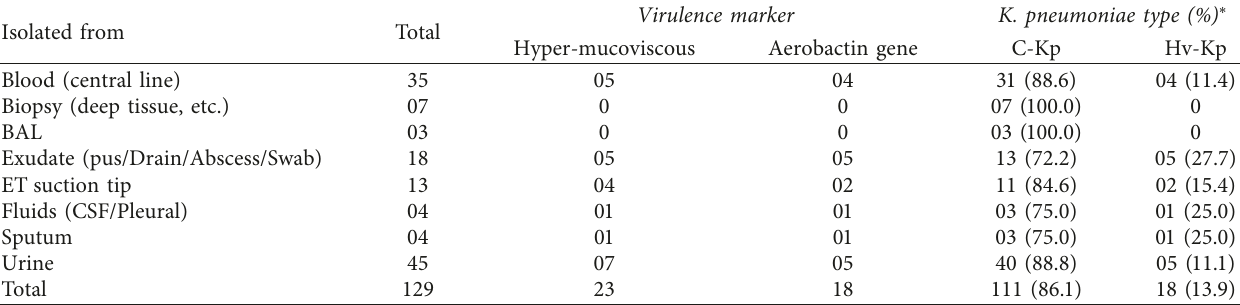
Table 2: Differentiation of Klebsiella pneumoniae isolates into classical (C-Kp) and hypervirulent (Hv-Kp) type based on phenotypic and genotypic markers.